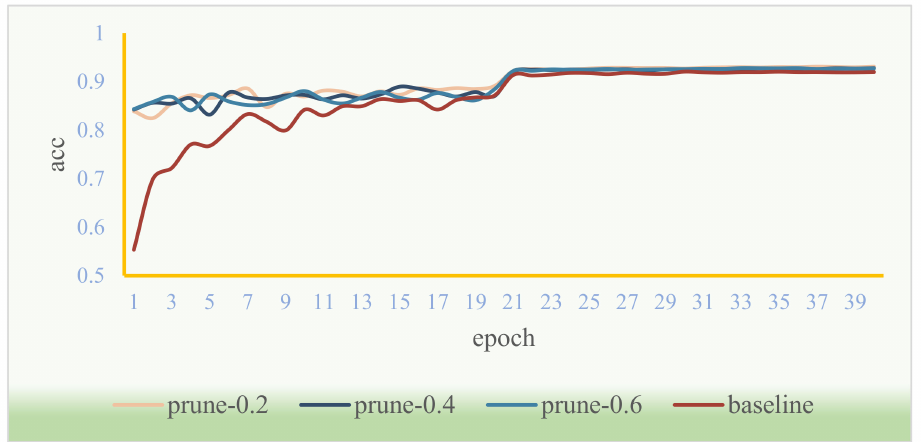
Figure 11. Comparison curve of